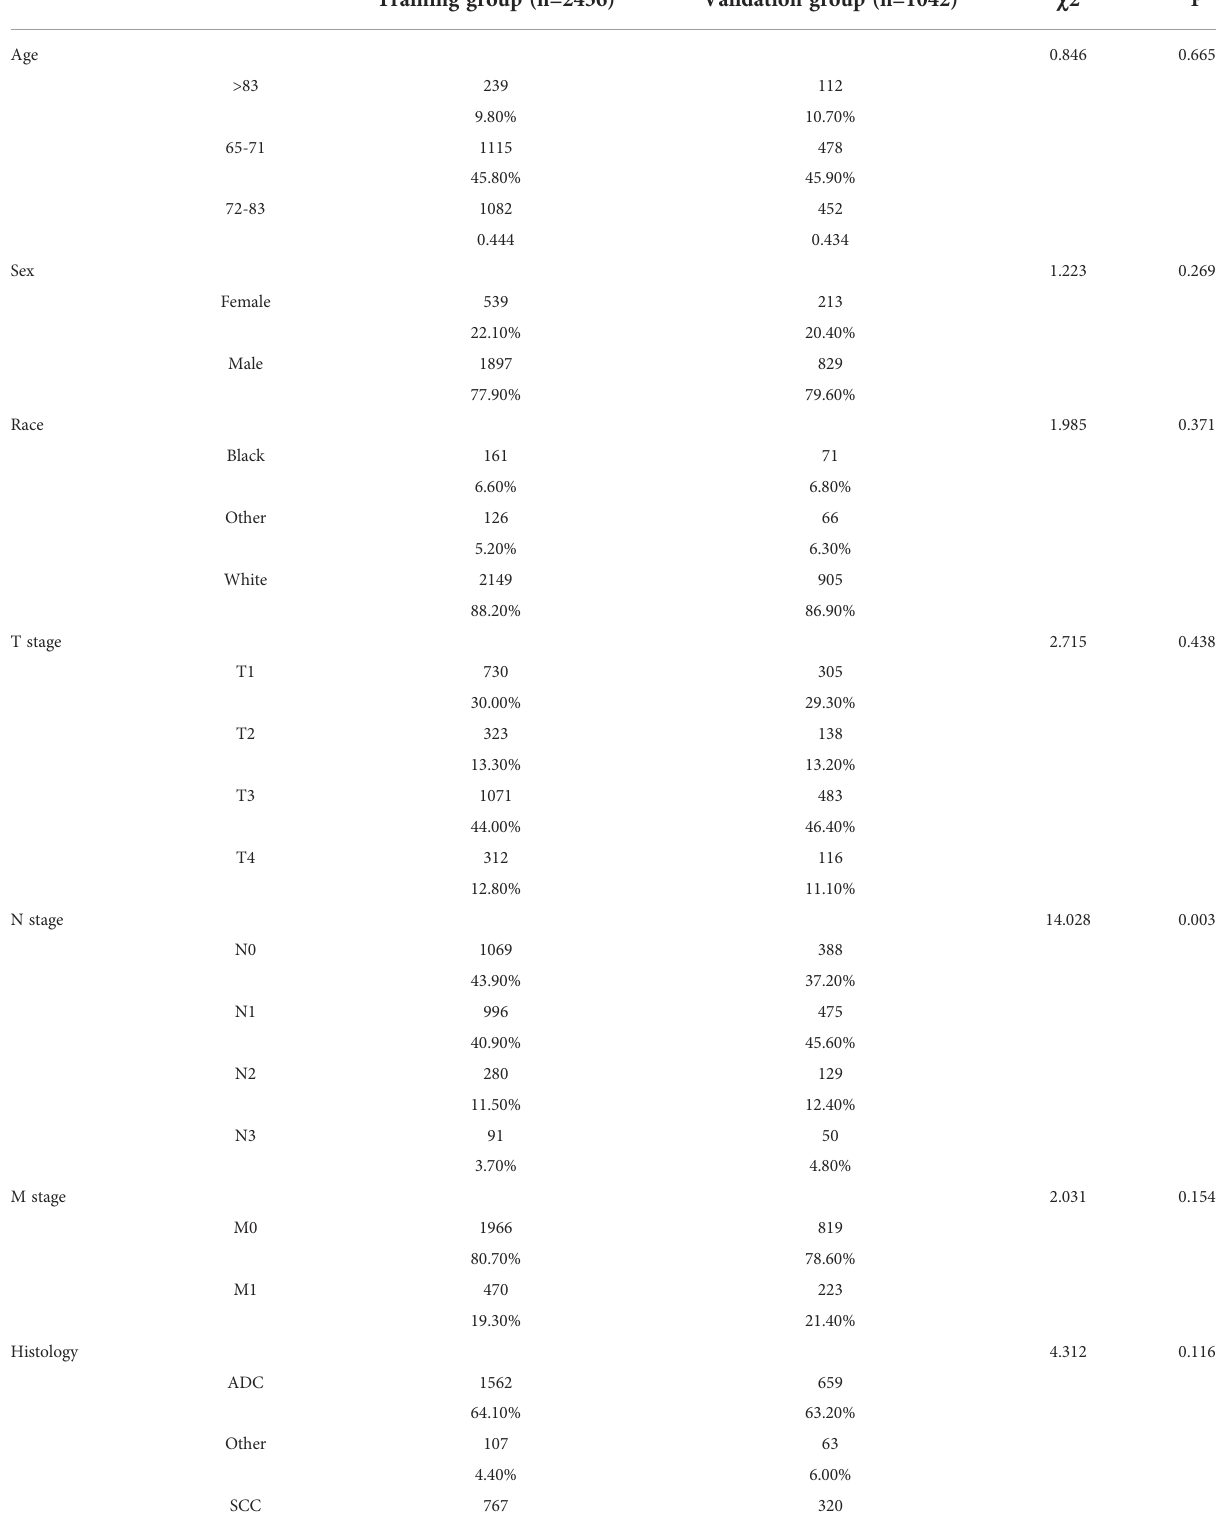
TABLE 1 Demographics and characteristics of patients in Training and Validation